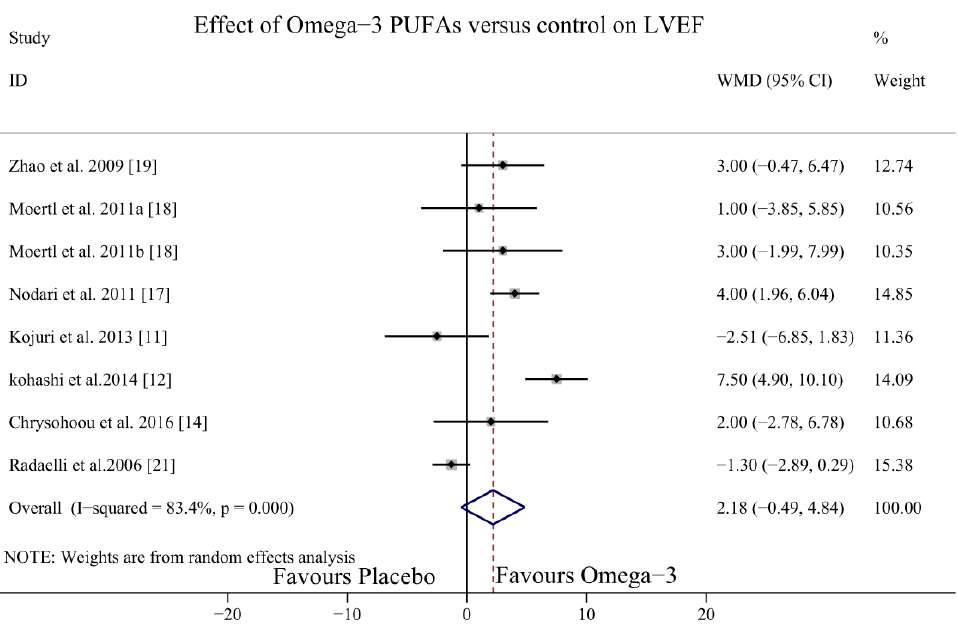
Figure 5. Forest plot depicting the effect of omega-3 PUFAs on LVEF (WMD, weighted mean difference). Abbreviations: LVEF, left ventricular ejection fraction; PUFAs, polyunsaturated fatty acids.